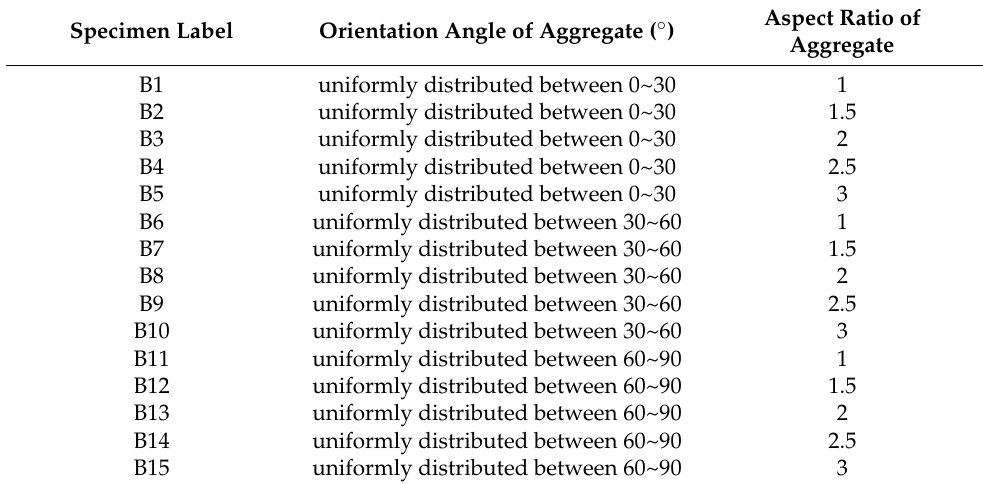
Table 2. The aggregate orientation and aspect ratio of asphalt concrete models.